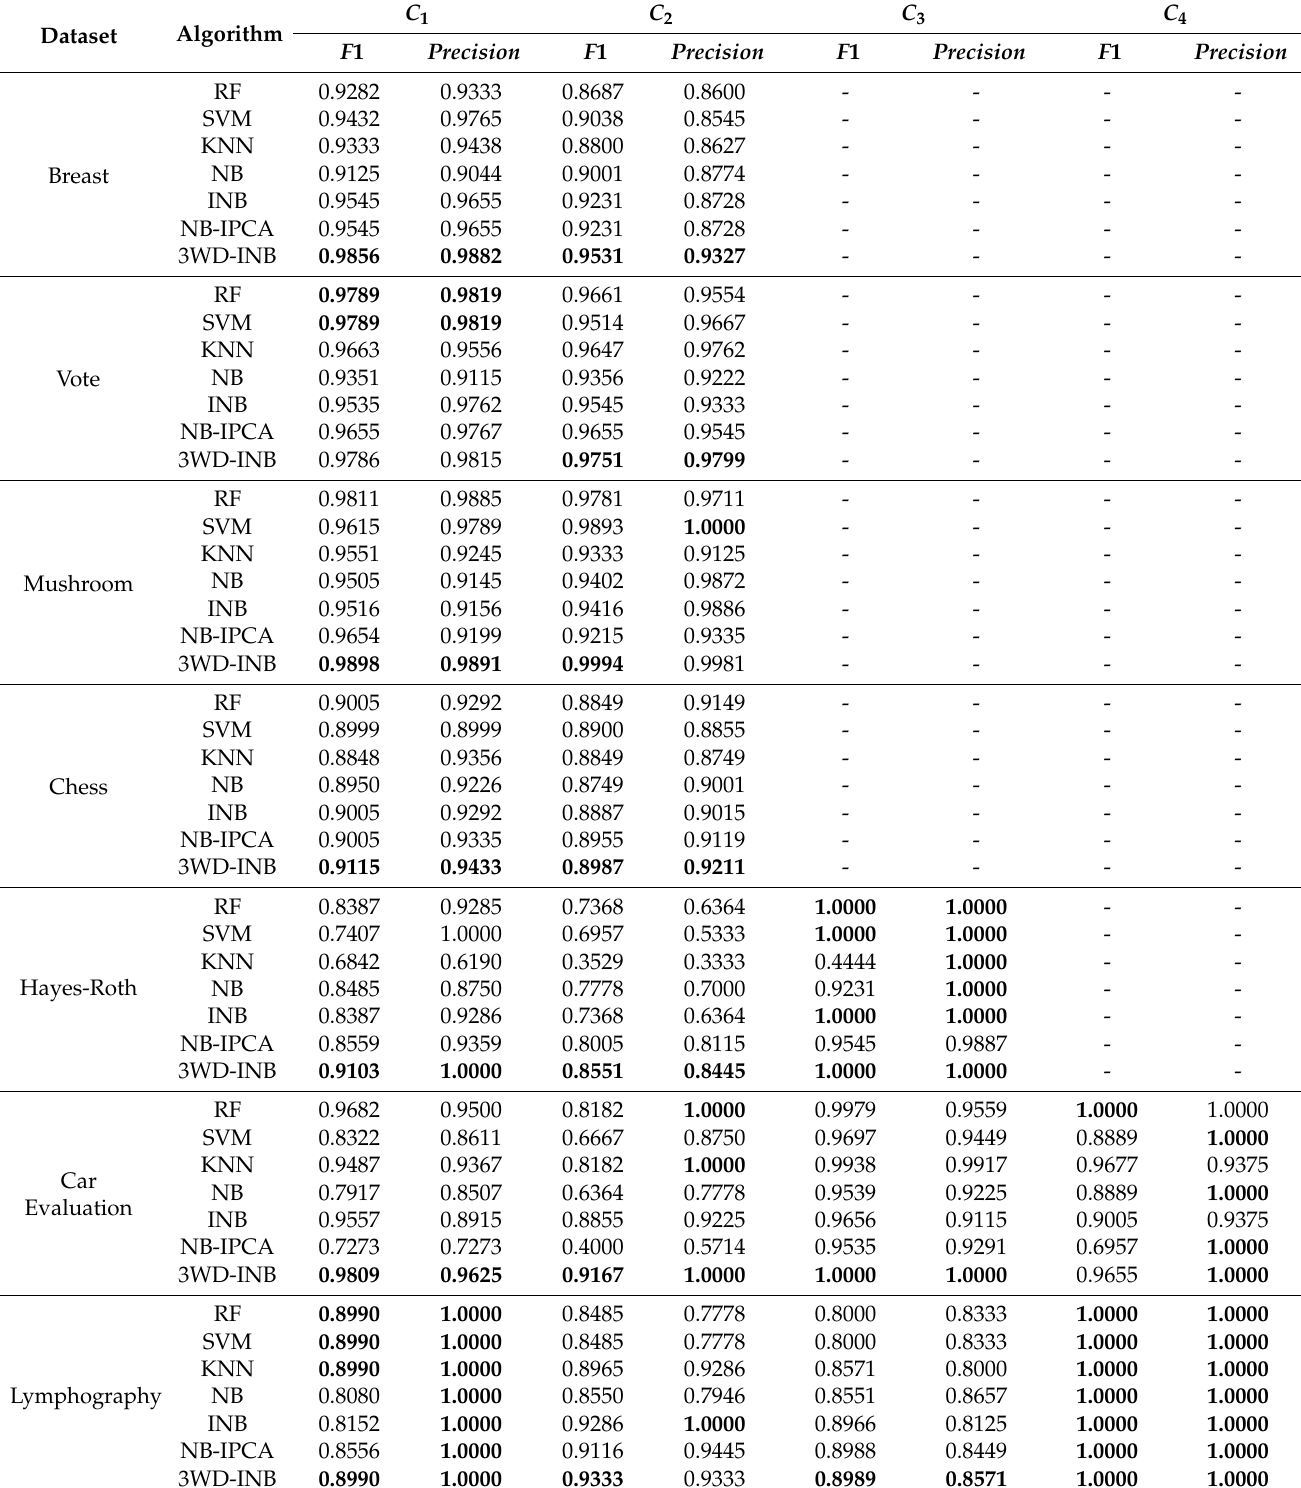
Table 8. 3WD-INB Experimental Result 1 (bold is the best